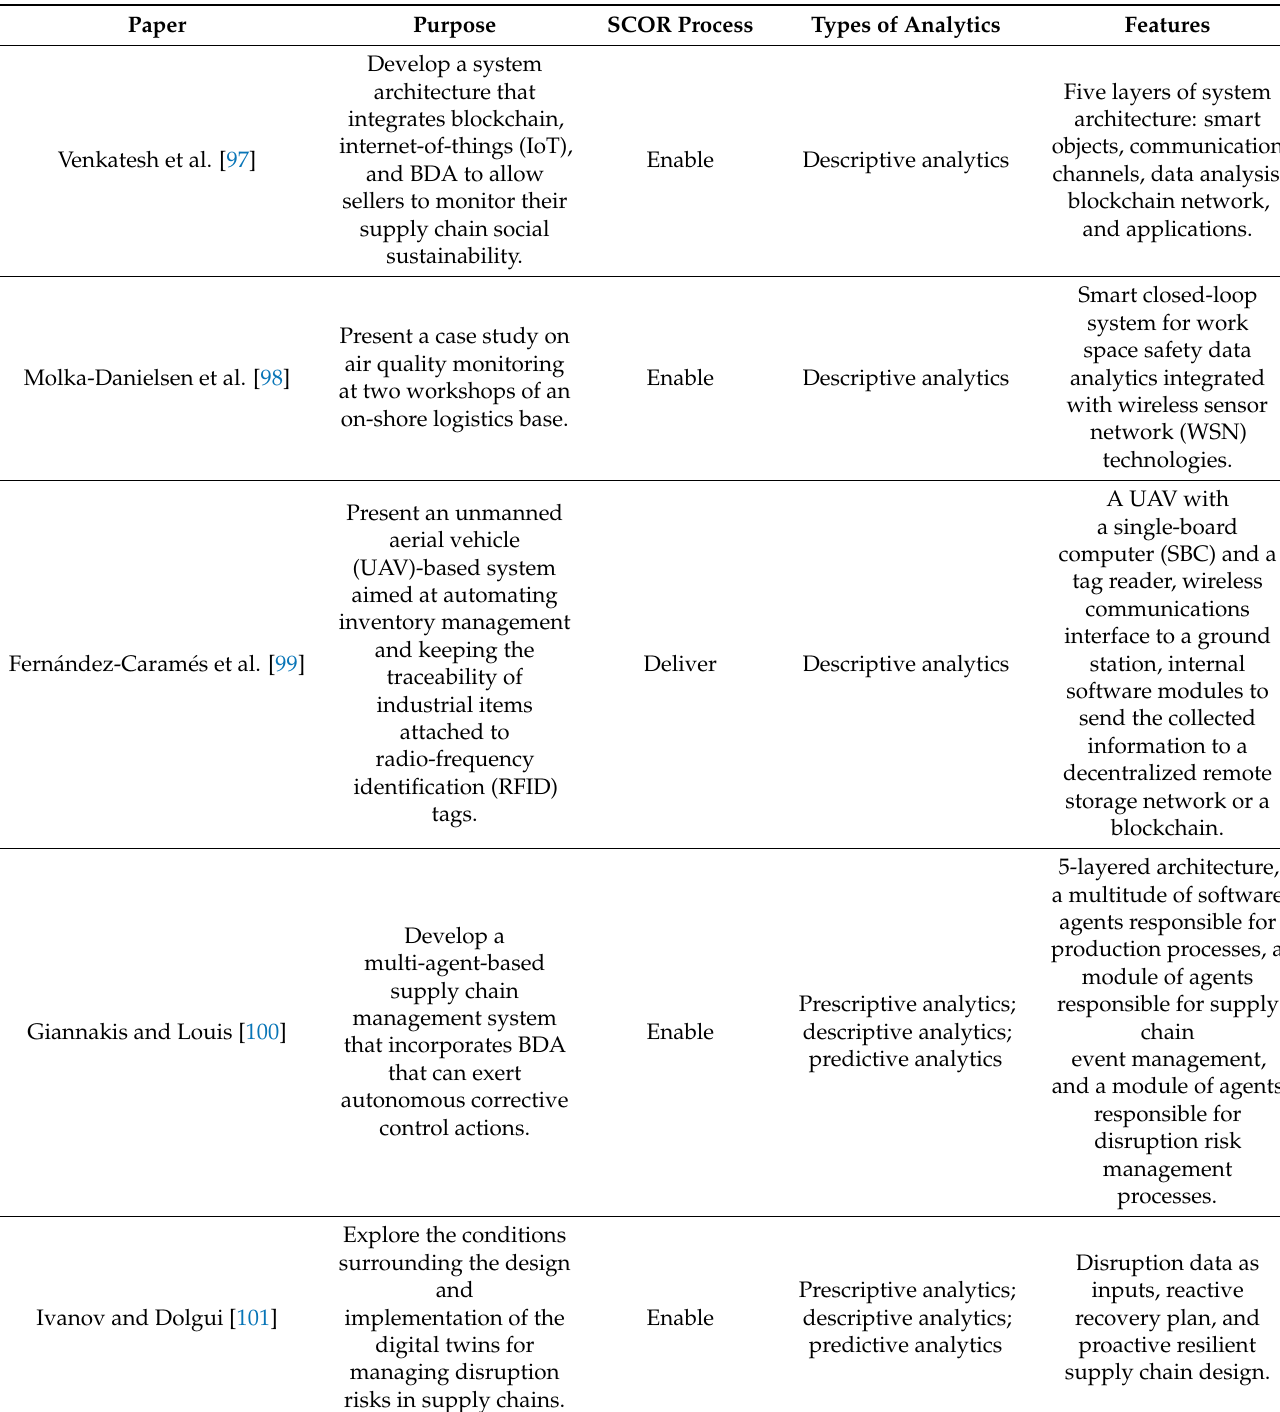
Table 8. Paper, purpose, SCOR processes, types of BDA, and features of